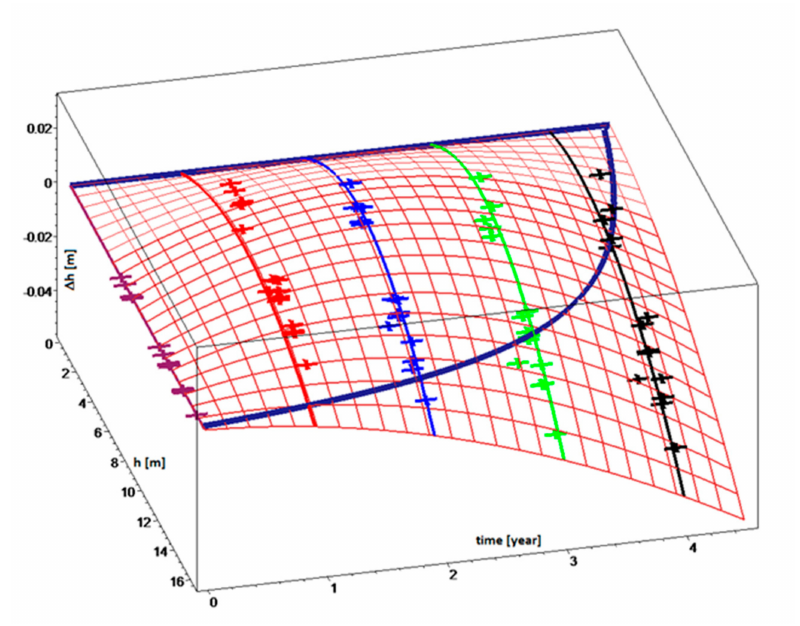
Figure 9. Vertical displacement in dependence on waste layer thickness and